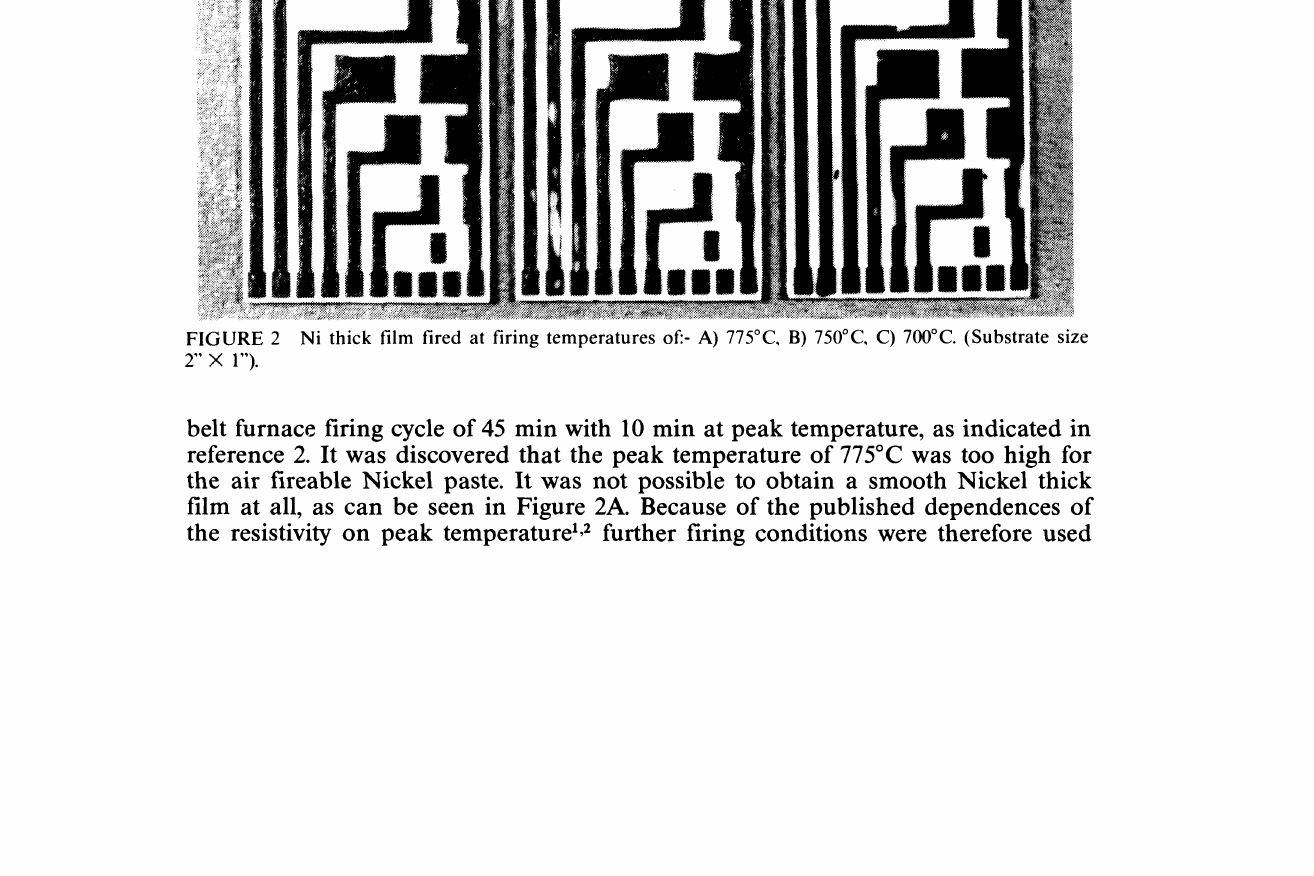
FIGURE Layout diagram (Substrate size 2"